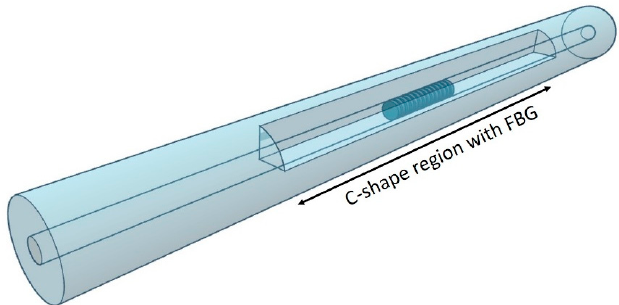
Figure 2. Schematics of a C-fiber with fiber Bragg grating spliced to standard single-mode fibers as an inline refractive index sensor.